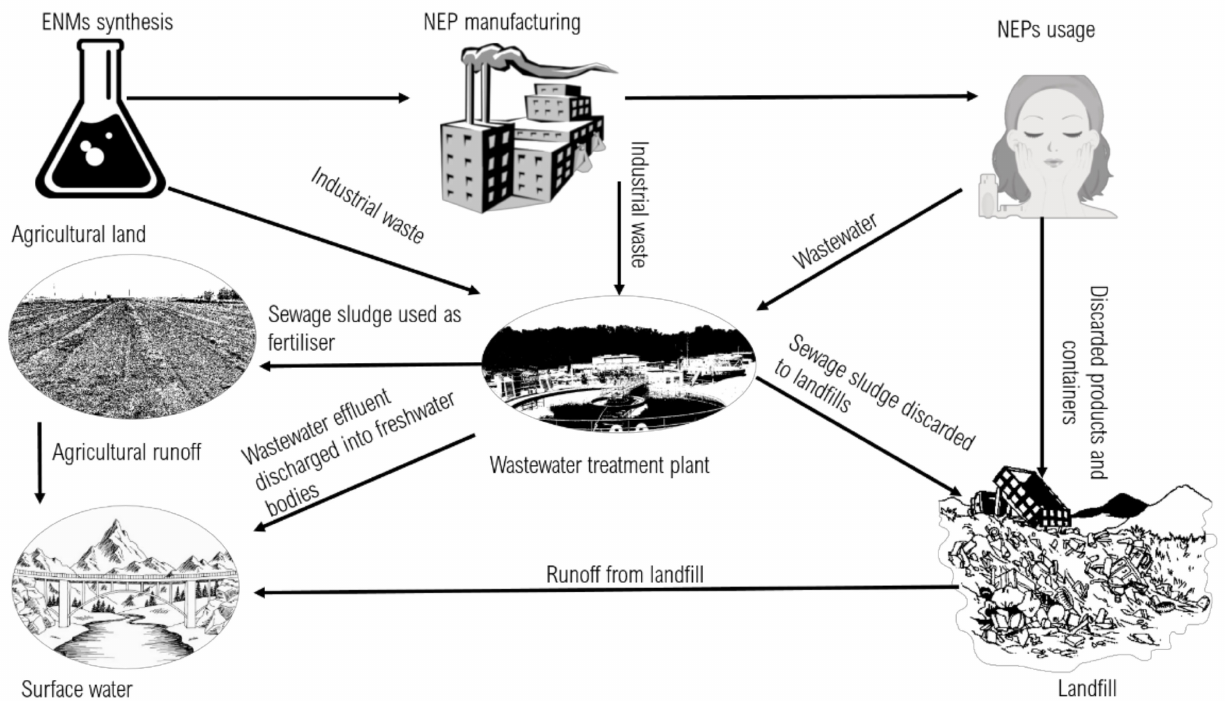
Figure 1. PR–ENMs pathway in the environment. The ENMs are depicted from manufacturing to different environmental exposure pathways in the environment.